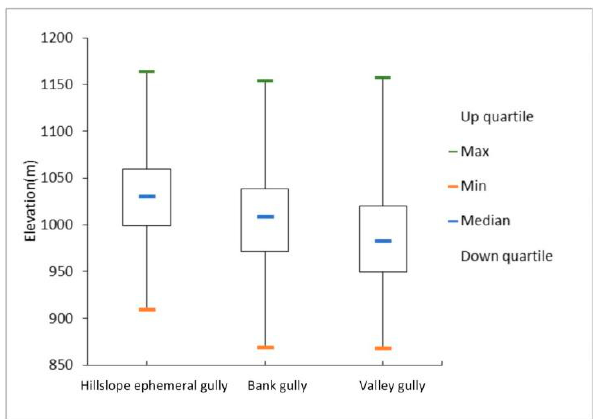
Figure 8. Elevation difference of three types of gullies.